Question: How would you classify this visualization?
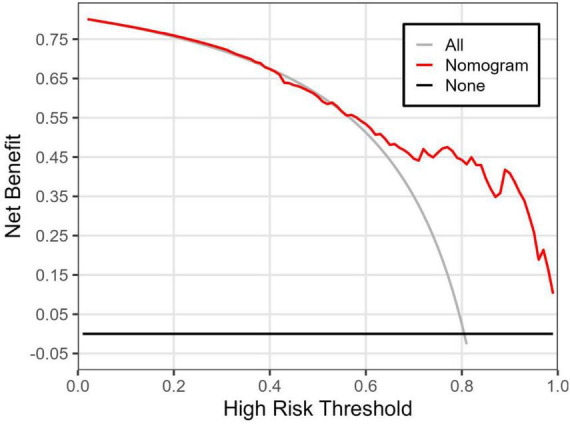
Answer: line